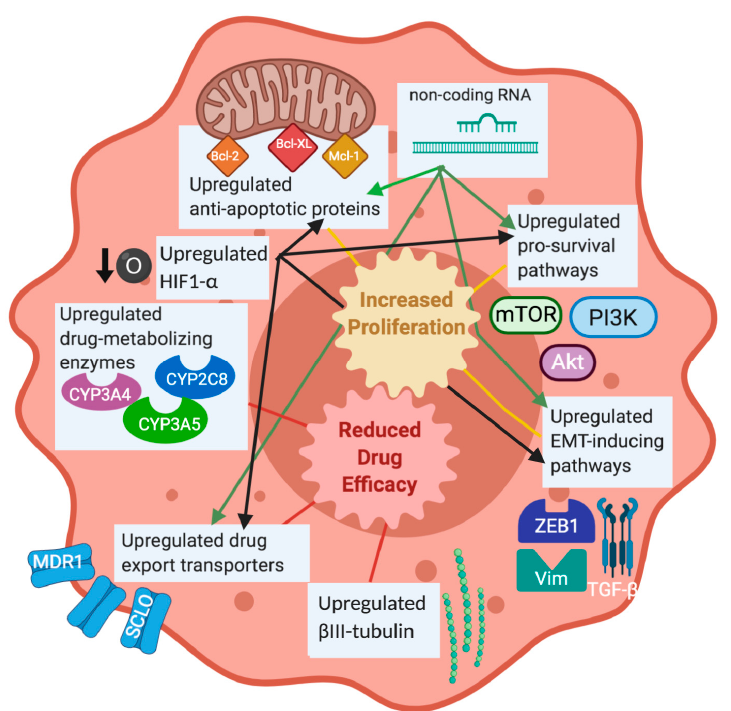
Figure 1. Overview of taxane resistance mechanisms. This diagram illustrates some of the major proteins and pathways that are known to contribute to taxane resistance in cancer. Upregulated pro-survival pathways, induction of EMT through upregulated vimentin, ZEB1, and TGF- β , and upregulated anti-apoptotic proteins have been linked with increased proliferation after taxane treatment. Upregulated tubulin isotypes, drug export transporters, and drug-metabolizing enzymes have been associated with reduced taxane efficacy. Hypoxia and non-coding RNAs have been noted to activate some of the established resistance mechanisms, so they will be considered to be contributing factors to taxane resistance as well. The review will include these mechanisms and others, which are frequently observed in different cancer types. Figure was made in BioRender.